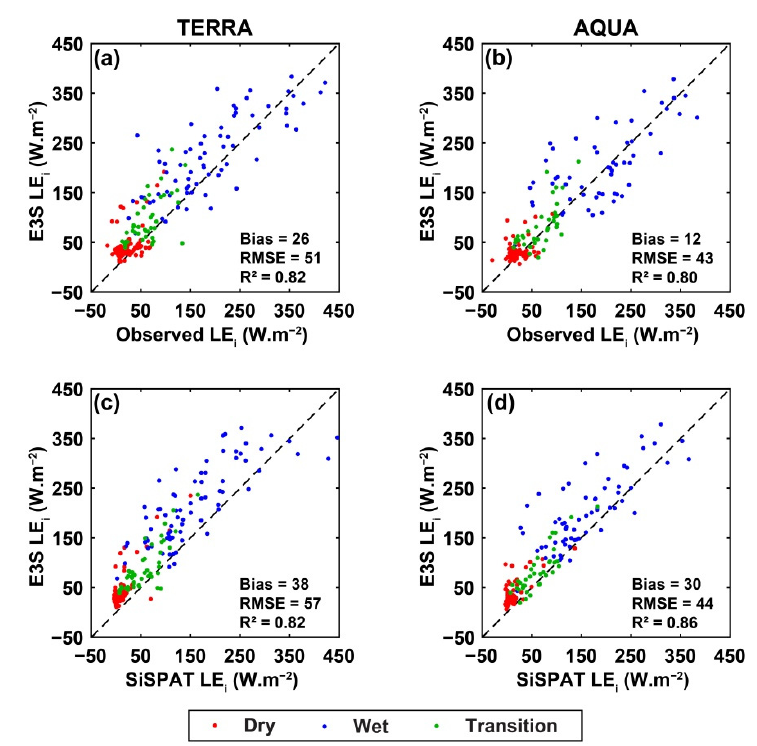
Figure 6. Comparing instantaneous latent heat flux ( LE ) estimated by E3S with plot observations ( a , b ) and SiSPAT simulations ( c , d ) at TERRA ( a , c ) and AQUA ( b , d ) overpass times. Evaporative fraction (EF and EF d )